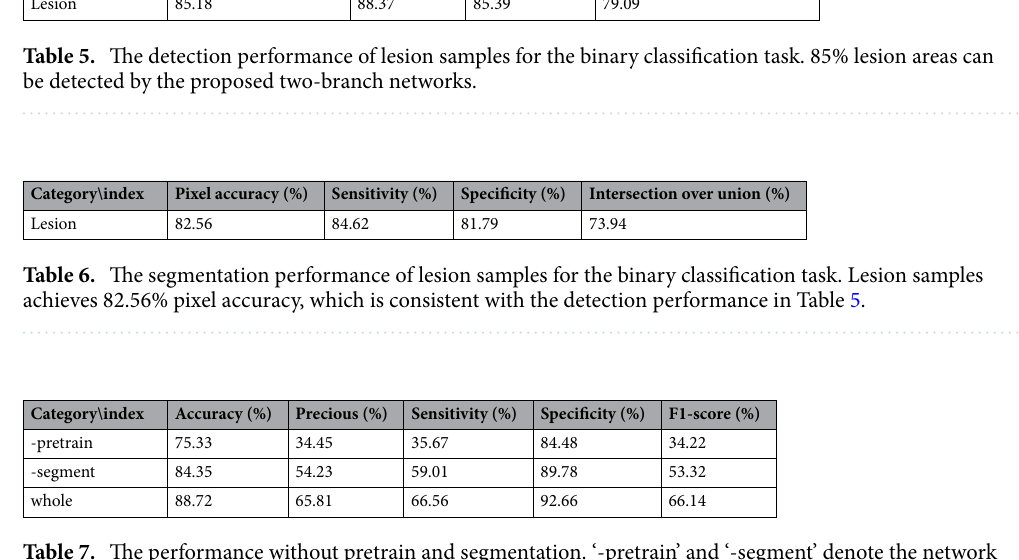
Table 7. The performance without pretrain and segmentation. ‘-pretrain’ and ‘-segment’ denote the network without the pretrain on healthy samples and segmentation branch, respectively. ‘whole’ denotes the whole